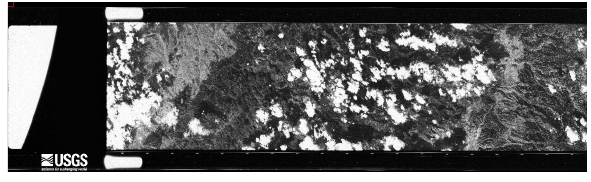
Figure 2. DISP original image